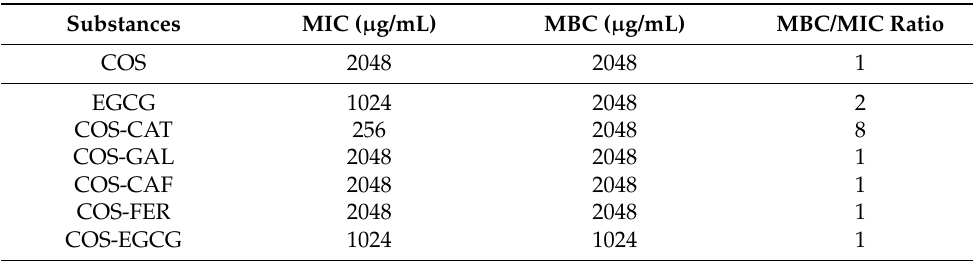
Table 1. Antibacterial activity of chitooligosaccharide (COS) and COS-polyphenol (PPN) conjugates (COS-PPN) against the reference strain of L. monocytogenes F2365. Substances MIC ( µ g/mL) MBC ( µ g/mL) MBC/MIC Ratio COS 2048 EGCG 1024 COS-CAT 256 2048 COS-GAL 2048 2048 COS-CAF 2048